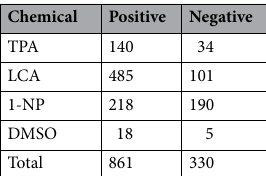
Table 2. Number of images of suspected foci in different